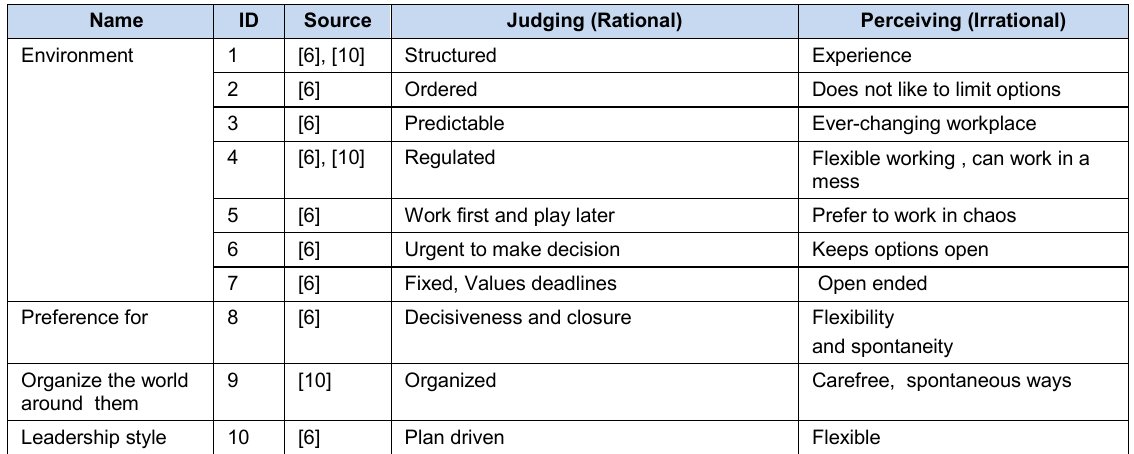
Table 4. Dimension